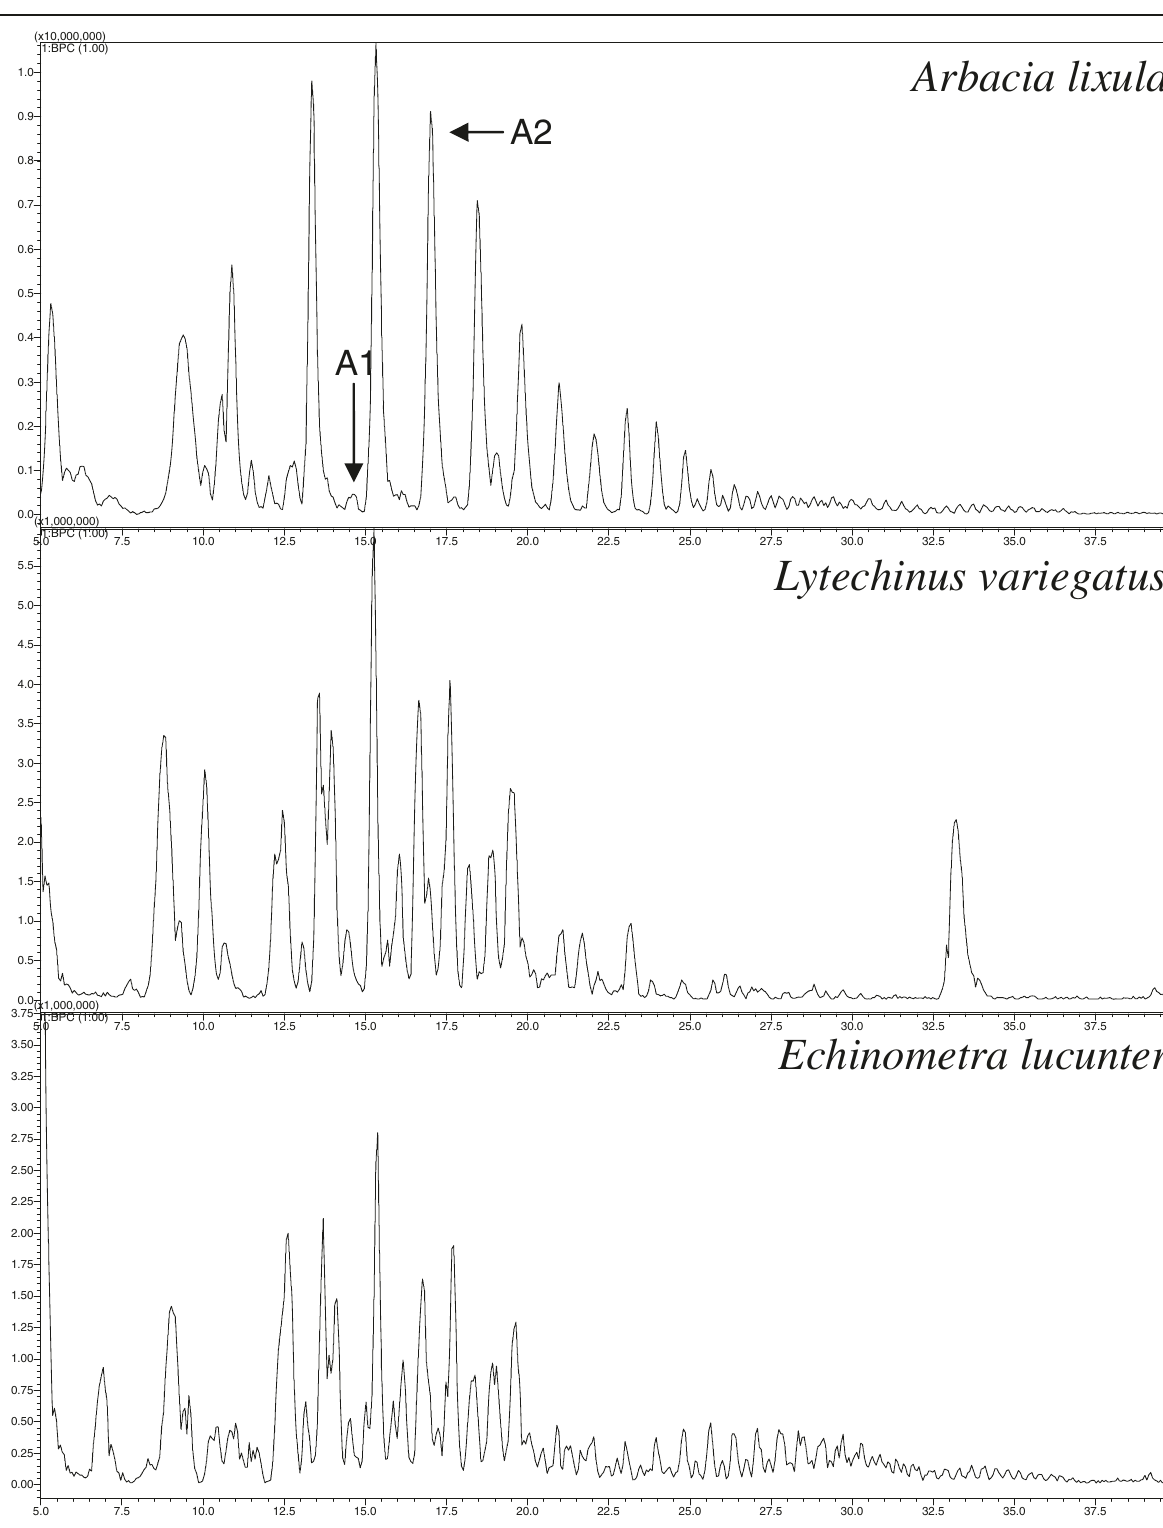
Fig. 1 TIC chromatograms of the RP-HPLC analyses of coelomic fluid from 25 % SPE of three sea urchins. A1 and A2 were selected as representative peaks to which complementary analyses are presented in Fig.